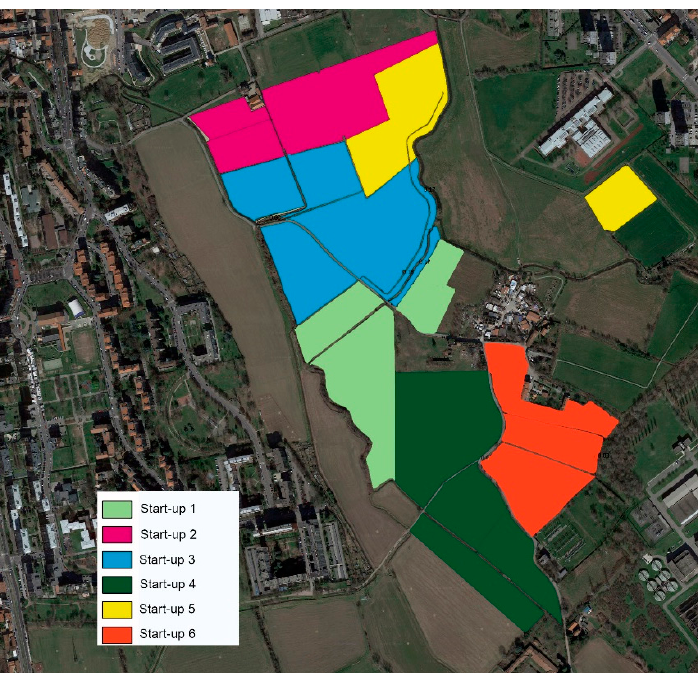
Figure 2. The sixth start-up divide in fields. Two start-ups (no. 1 and 3) do not directly cultivate fields, so they are not relevant on the map.